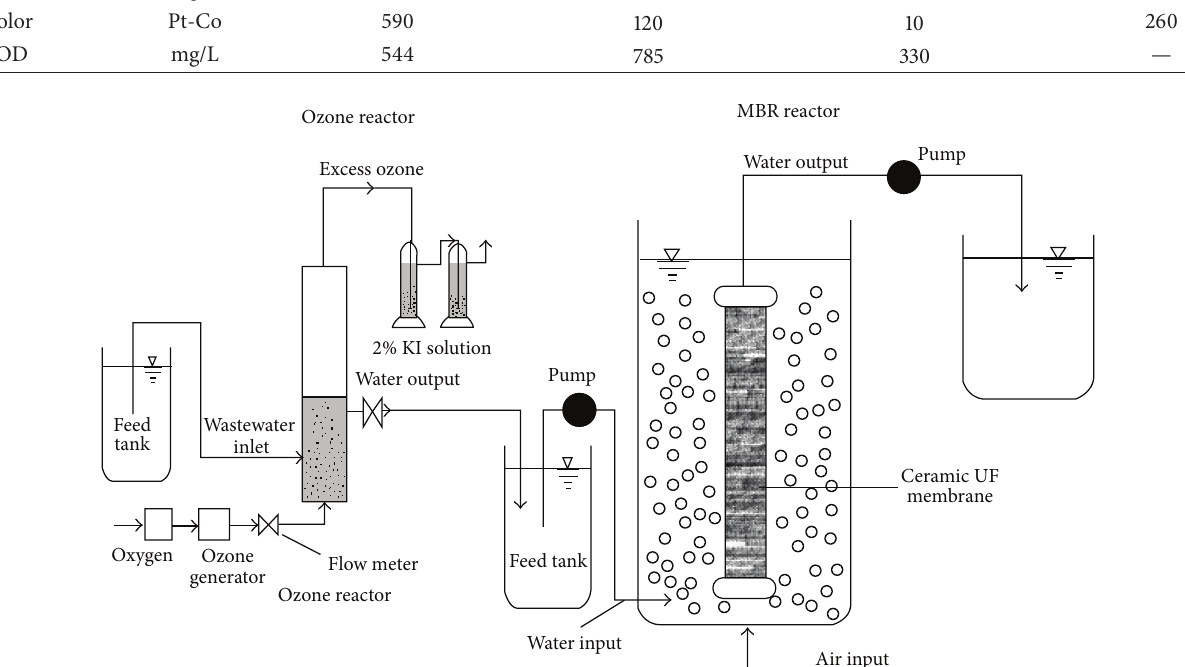
Figure 1: Schematic representation of the ozone and MBR